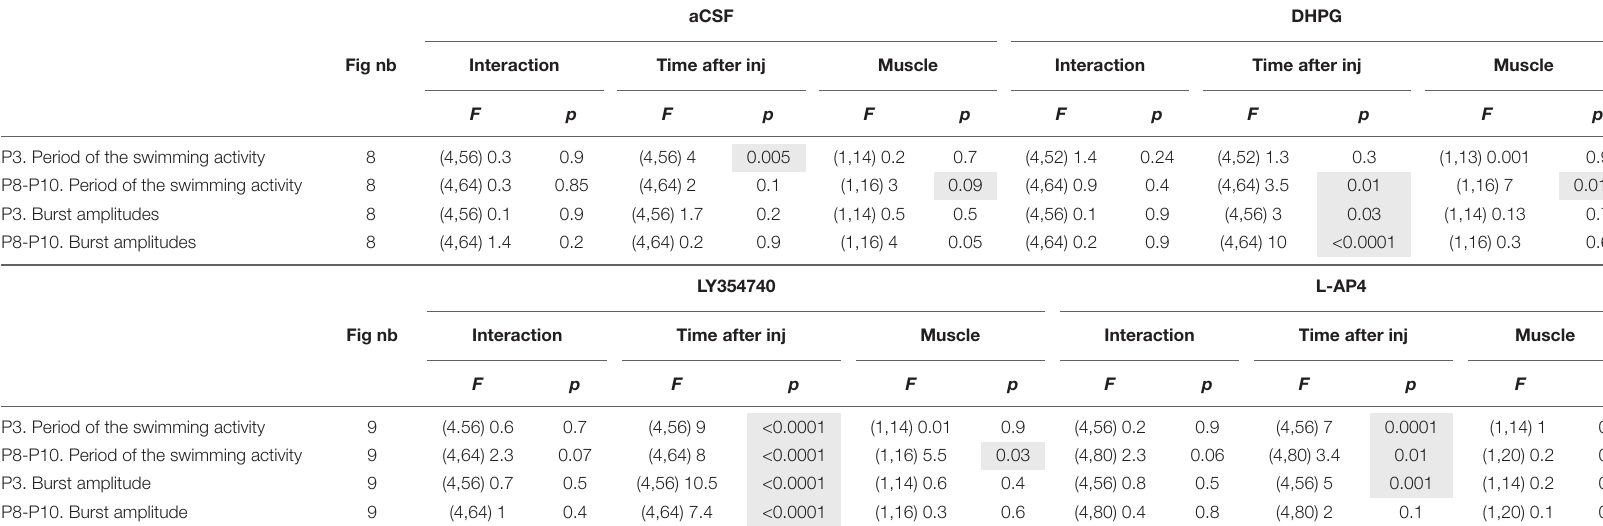
The numbers into brackets correspond to the degrees of freedom. Fig nb, number of the corresponding Figure. Shaded cells, p < 0.05 significantly